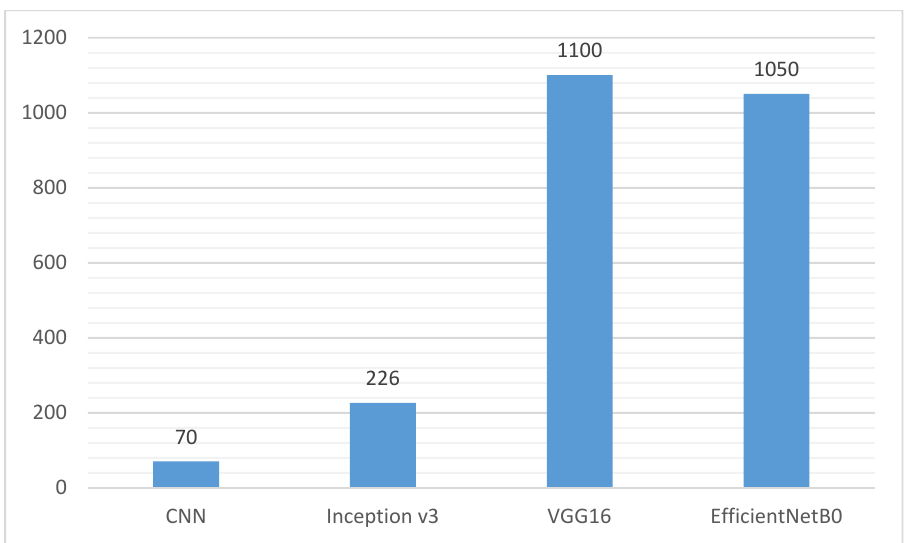
Figure 6. Epoch training time of each model in seconds.